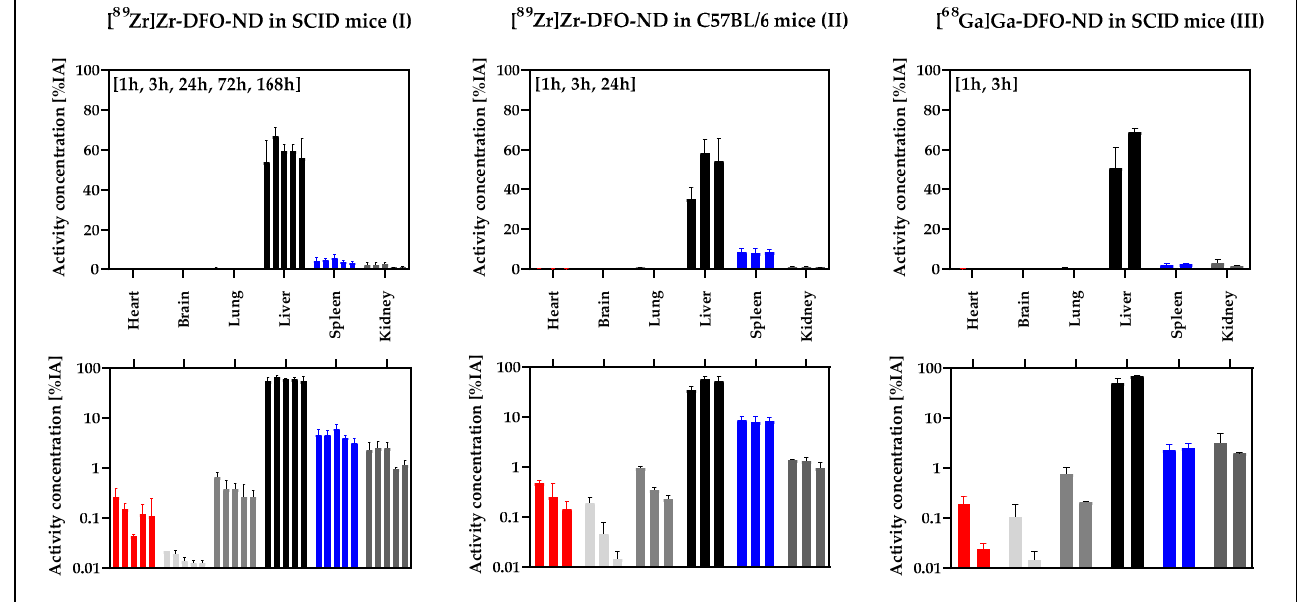
Figure 6. Biodistribution of radiolabeled NDs in %IA (mean and SD) for the various models. The gamma counter-based evaluation is presented in linear scale (upper row) and logarithmic scale (lower row). Only fully excised organs were included for evaluation in %IA. Of the total applied activity (100%) about 60% was accumulated in the liver (black) over time, while less than 10% was detected in the spleen (blue), kidney and lung.